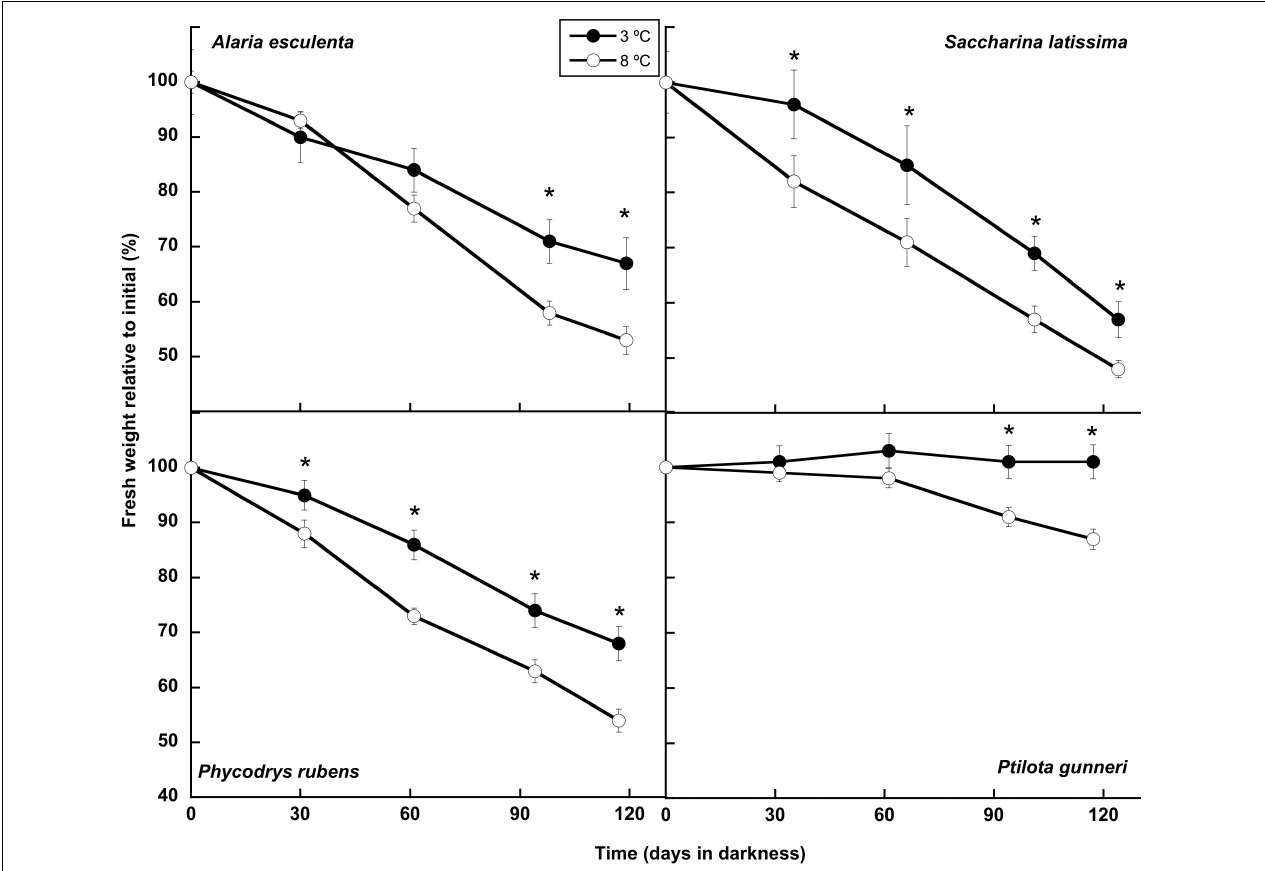
FIGURE 1 | Biomass evolution during the 16 weeks of incubation in darkness of Alaria esculenta , Saccharina latissima , Phycodrys rubens , and Ptilota gunneri at two different temperatures. Data are mean of 5 replicates (error bars for standard deviation). Significant differences between temperatures marked with an